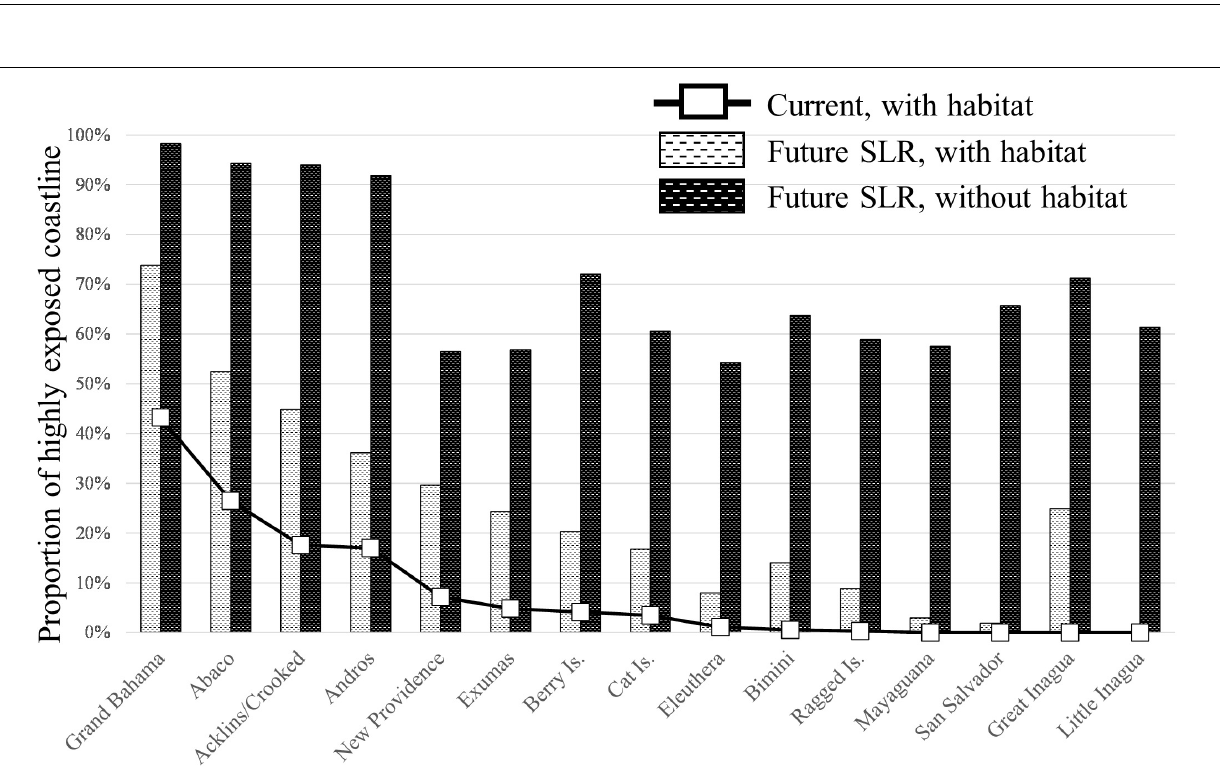
Frontiers in Marine Science |